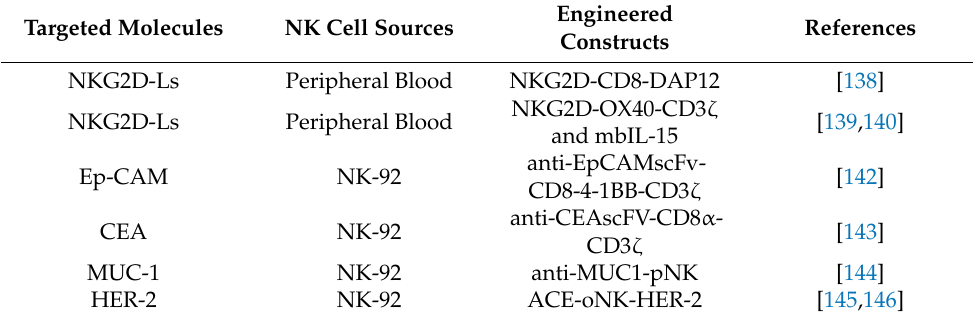
Table 1. Current preclinical studies describing engineered NK cells to target